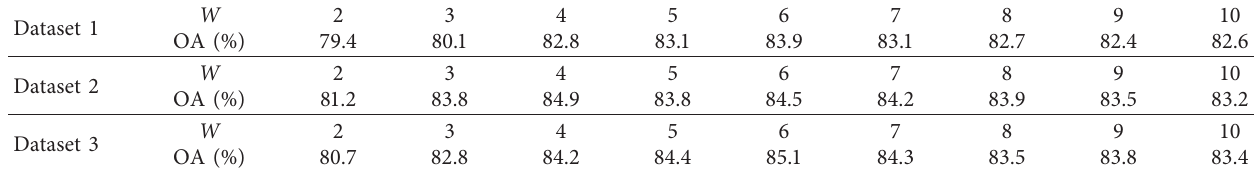
Table 8: Detailed W-OA values in three dataset